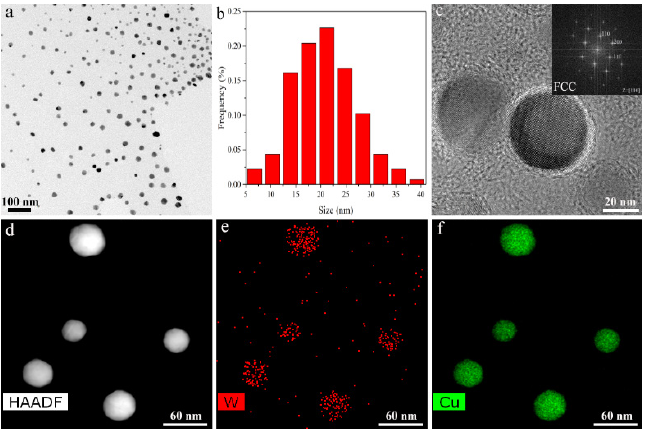
Figure 4. Characterization of microstructure and chemical composition of alloyed W50Cu50 BNPs. ( a ) TEM image of W50Cu50 BNPs, ( b ) size-distribution diagram of alloyed BNPs. ( c ) HRTEM image of W50Cu50 single-particle; inset is corresponding FFT pattern. ( d ) HAADF image of W50Cu50 BNPs. ( e , f ) EDS image of W and Cu element, respectively.